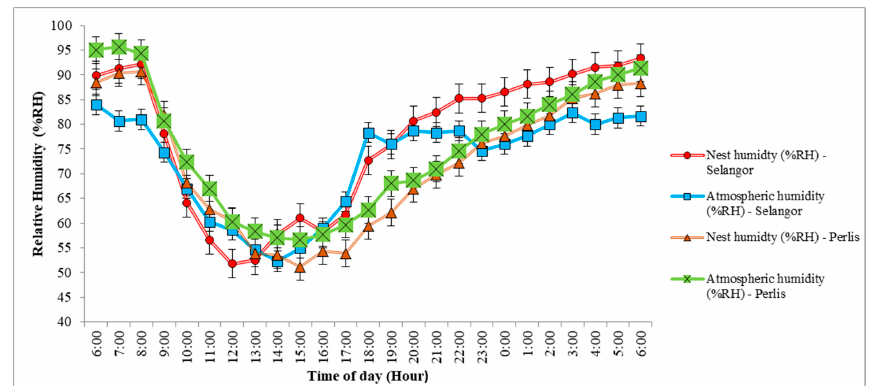
Figure 3. Baya weaver ( Ploceus philippinus ) nest temperature (°C) and atmospheric temperature (°C) across 34 nests in Selangor and 32 nests in Perlis, Malaysia.